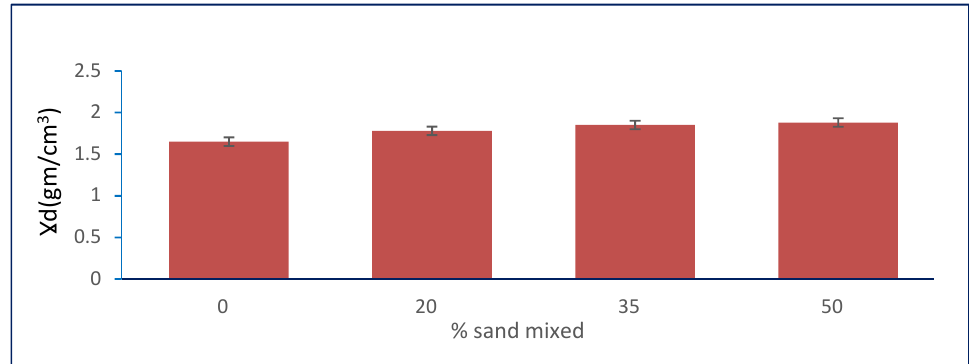
Figure 14. Effect of sand on maximum dry density.